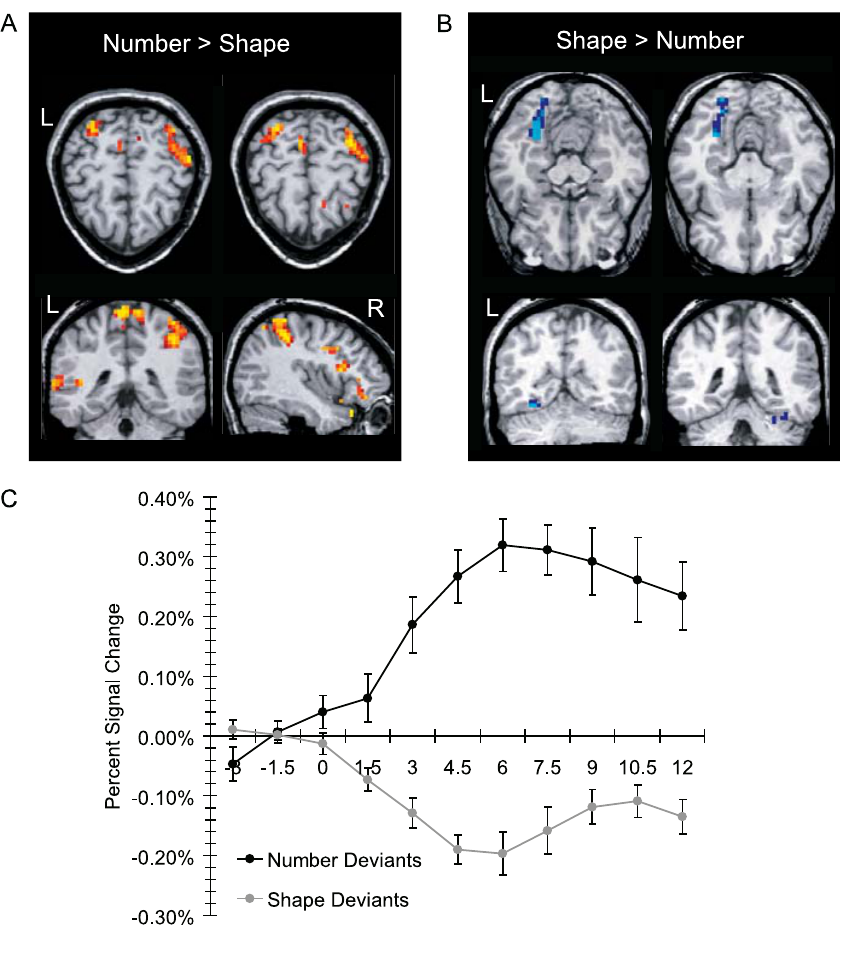
Figure 2. Adult Participant’s fMRI Results (A) Regions that were more active during the presentation of number compared to shape deviants ( p , .05, cluster size . six functional voxels). (B) Regions that were more active during the presentation of shape compared to number deviants ( p , .05, cluster size . six functional voxels). (C)